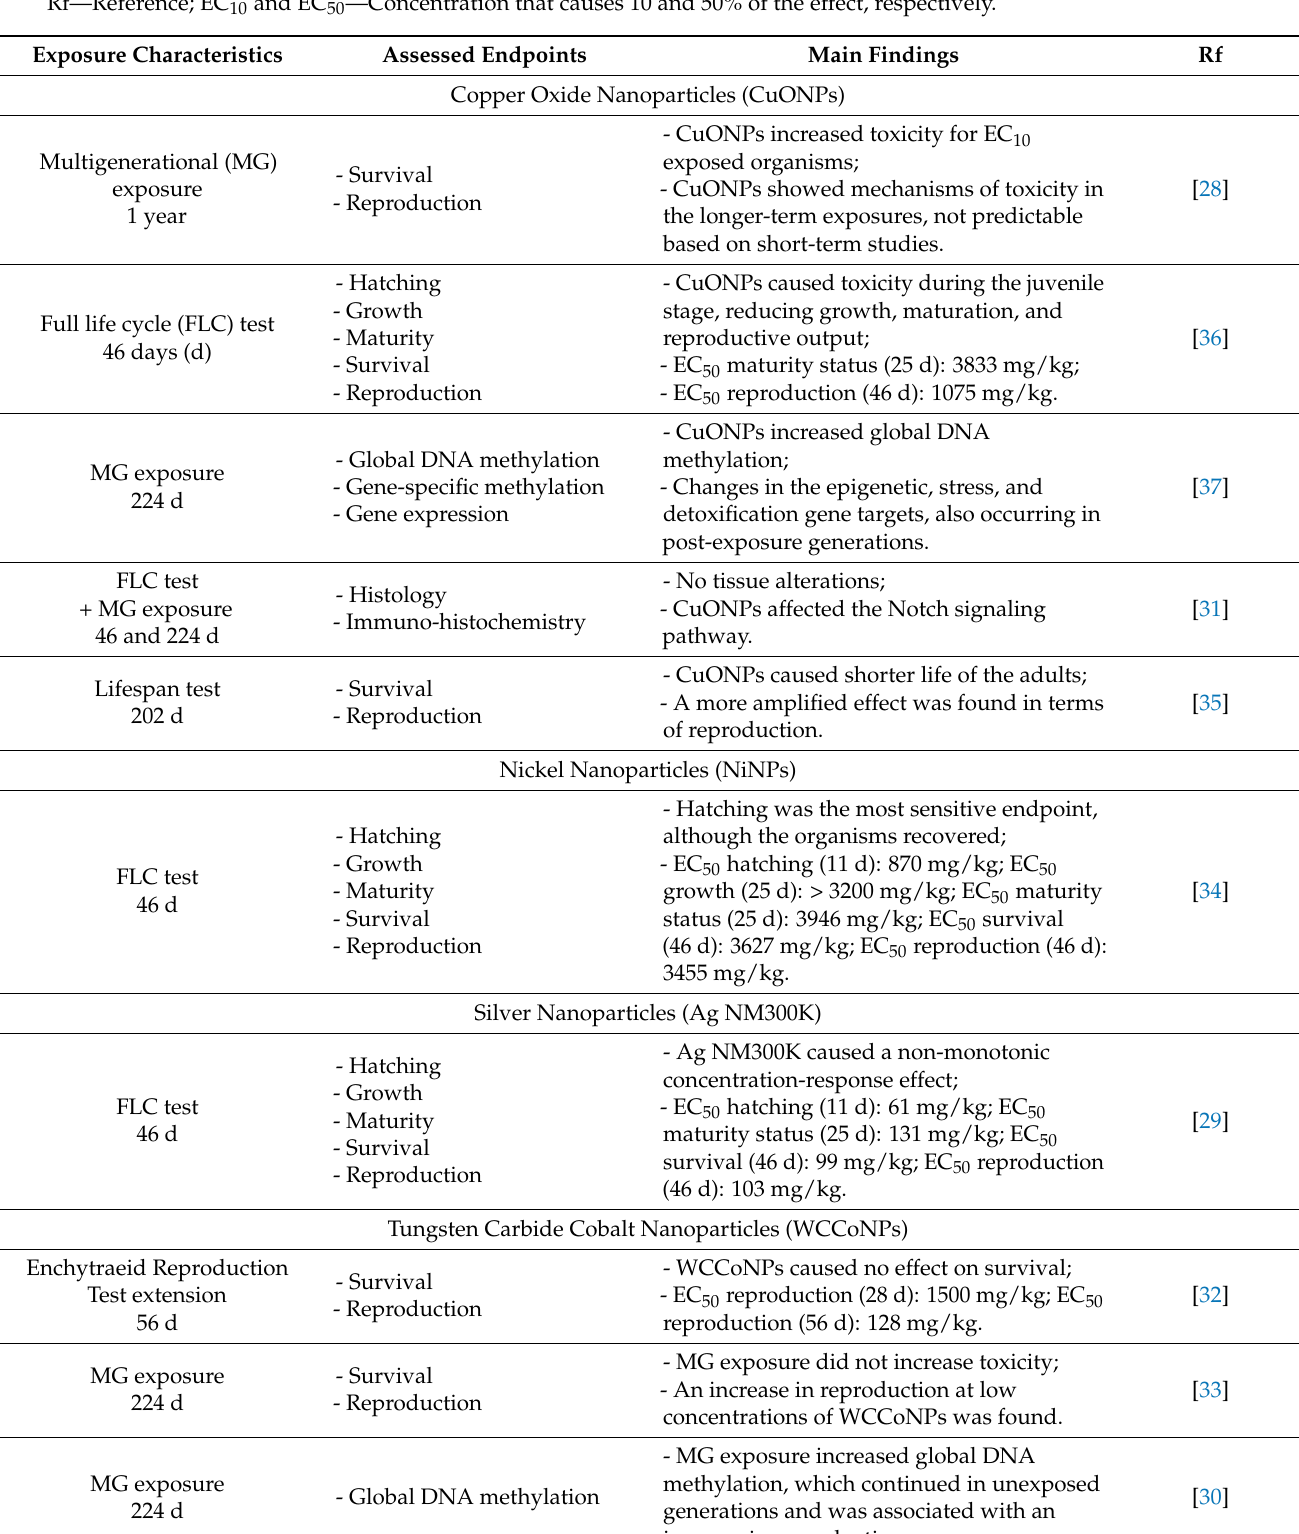
Table 1. Studies assessing the long-term effects of engineered nanoparticles to the terrestrial species Enchytraeus crypticus . Rf—Reference; EC 10 and EC 50 —Concentration that causes 10 and 50% of the effect,